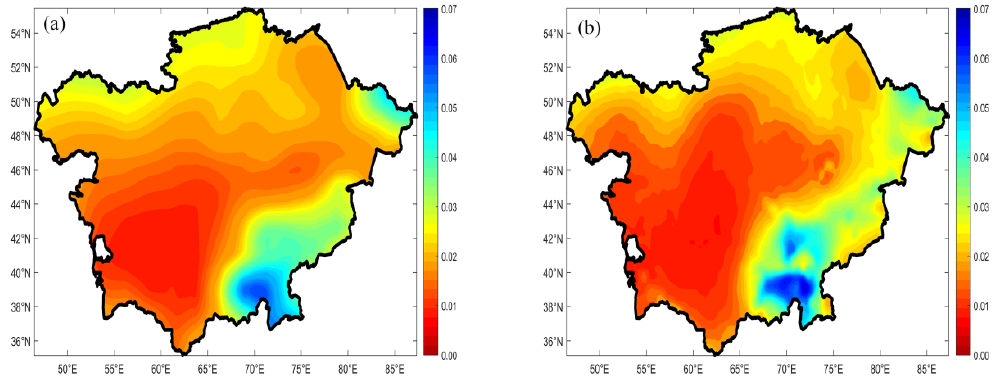
Figure 5. The empirical orthogonal function (EOF1) of CMIP5 MME ( a ) and the EOF1 of CRU ( b ).